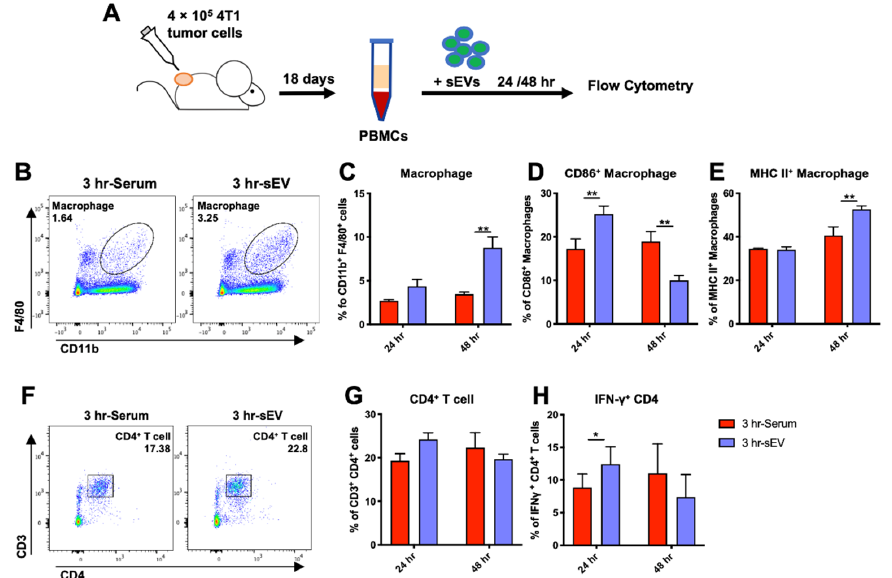
Figure 7. sEVs released after cryo ‐ thermal therapy promoted the maturation of macrophage ‐ like monocytes and CD4 + T differentiation toward Th1 in vitro. ( A ) Schematic of experimental design. PBMCs from tumor ‐ bearing mice were incubated with sEVs derived from cryo ‐ thermal treated mice at 20 μ g/mL or PBS in vitro for 24 or 48 h. ( B ) Flow cytometry gating strategy for determination of CD11b + F4/80 + macrophages in PBMCs. ( C – E ) The proportions of macrophages( C ), CD86 + macrophages( D ), and MHC II + macrophages ( E ) were determined by using flow cytometry. ( F ) Flow cytometry gating strategy for the determination of CD3 + CD4 + T cells in PBMCs. ( G – H ) The proportions of CD4 + T cells( G ) and IFN ‐γ + CD4 + T cells( H ) were determined by using flow cytometry. Data were shown as mean ± SD, and the Student’s t ‐ test was used for statistical analysis. n = 4, * p < 0.05, ** p < 0.01 compared with the control group.